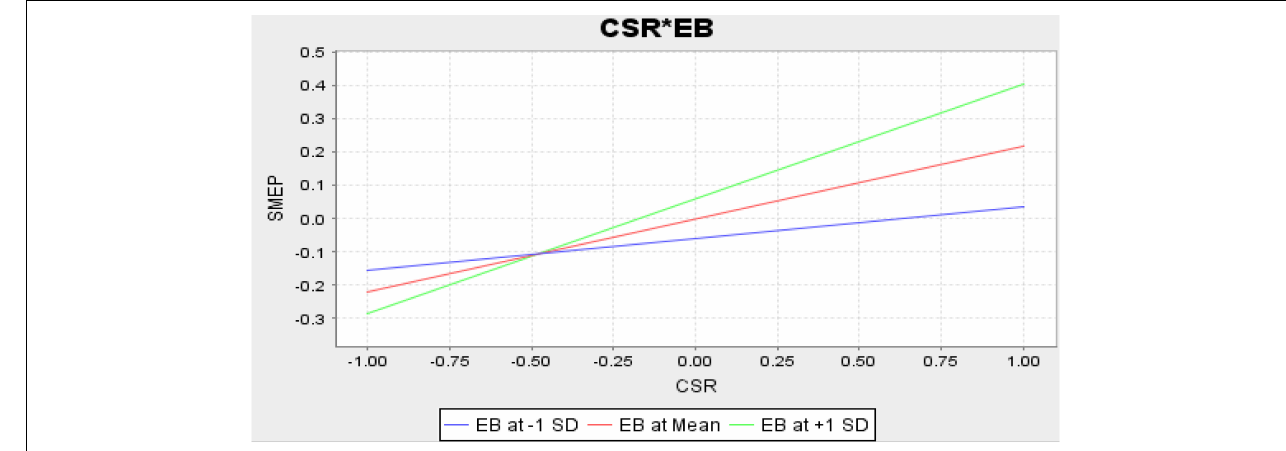
FIGURE 5 | Corporate social responsibilities (CSR) × Employee behavior (EB).